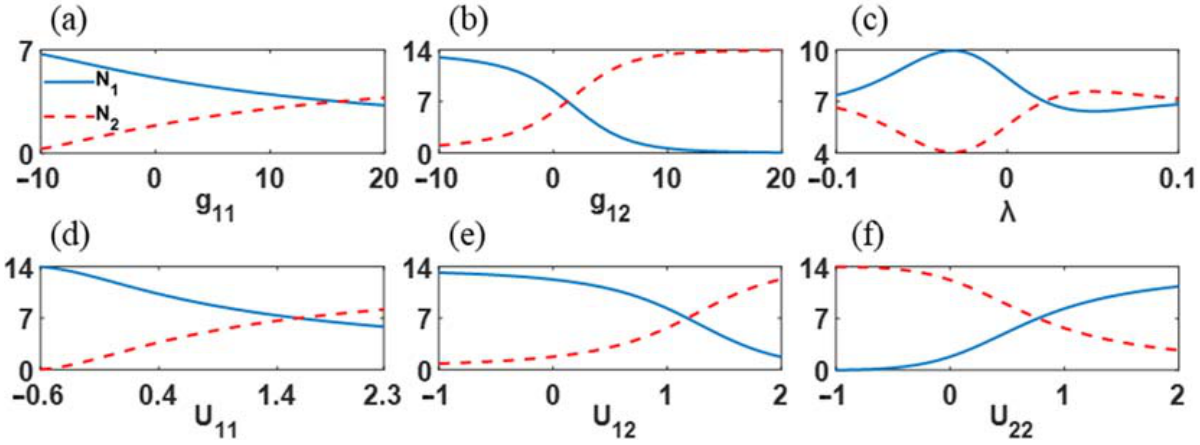
Figure 2. Relationship of spin-up and spin-down atom numbers N 1 and N 2 , respectively, with the local and nonlocal parameters. The parameters chosen were the local nonlinear strength g 11 ( a ) and g 12 ( b ), spin–orbital coupling strength λ ( c ), and nonlocal nonlinear strength U 11 ( d ), U 12 ( e ) and U 22 ( f ) for spin up (blue line, N 1 ) and spin down (red line, N 2 ). The other fixed parameters were g 11 = 0.1, g 12 = g 21 = g 22 = 0.3, U 11 = U 12 = U 21 = U 22 = 1, λ = 0.001, and µ = 1.003. For more information on the atom numbers with spin-up and spin-down modes, the ratio N 1 / N 2 with respect to g 11 , g 12 , λ , and U ij ( i , j = 1, 2 ) was plotted in Figure 3. It indicated that the ratio N 1 / N 2 decreased monotonously with g 11 , g 12 , U 11 , and U 12 , and increased monotonously with U 22 . Comparing with Figure 2, we found that the dominant parameters were atom mode could be tuned by g 12 , U 12 , and U 22 effectively. In Figure 3c, we found that the number of atoms was sensitive to the change of the spin–orbital coupling strength λ . The ratio N 1 / N 2 had a single peak with the change of λ , which indicated that the atoms with the spin-up mode were predominant only with a small range of λ , around − 0.05 < λ < 0. In order to obtain the stability of the solitons in the nonlinear media, the relation of the energy E and the chemical potential with respect to N were studied and shown in